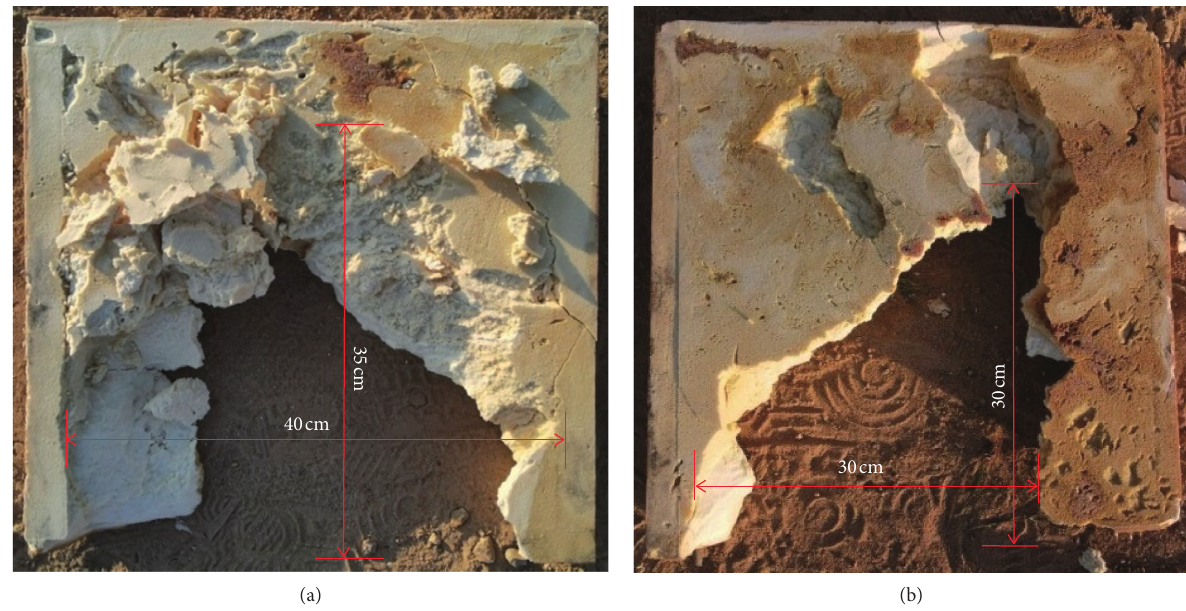
Figure 8: Test results of polymer slab B0 (close-in explosion). (a) Top surface. (b) Bottom surface.